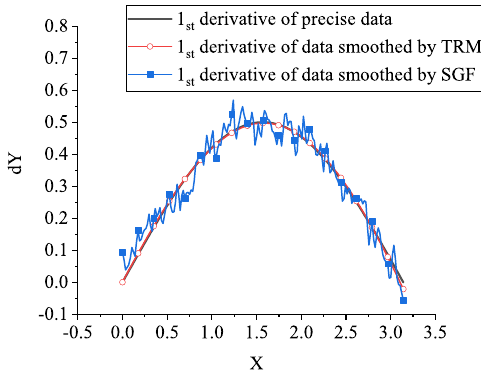
Figure A2. Comparing the first derivative of data smoothed by Tikhonov regulation method (TRM, red line) and Sativetzky–Golay filtering method (SGF, blue line) with y (cid:48)